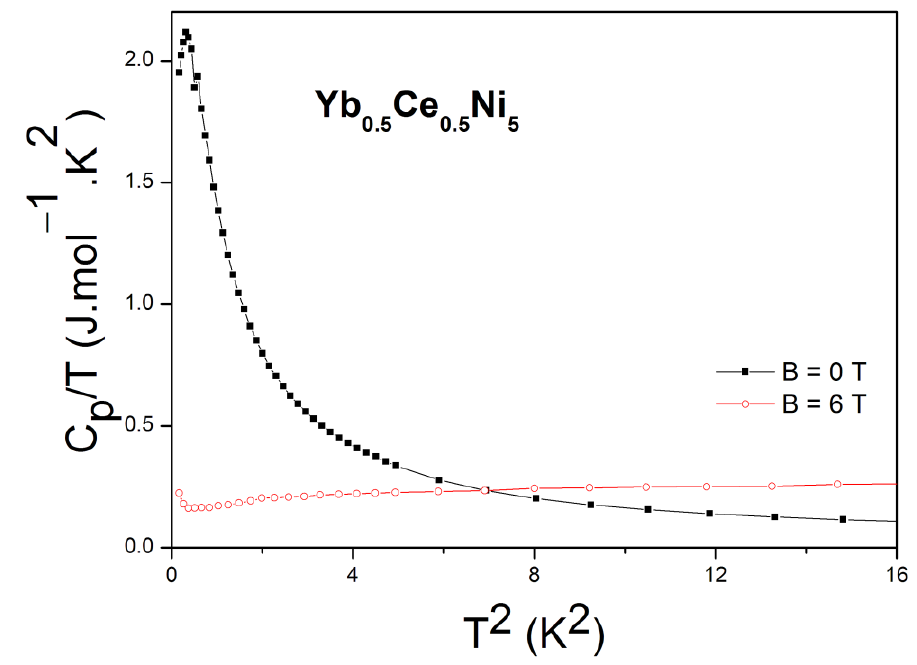
Figure 3. Low-temperature detail of the heat capacity measurement of Yb 0.5 Ce 0.5 Ni 5 compound vs. T 2 for B = 0 and 6 T.